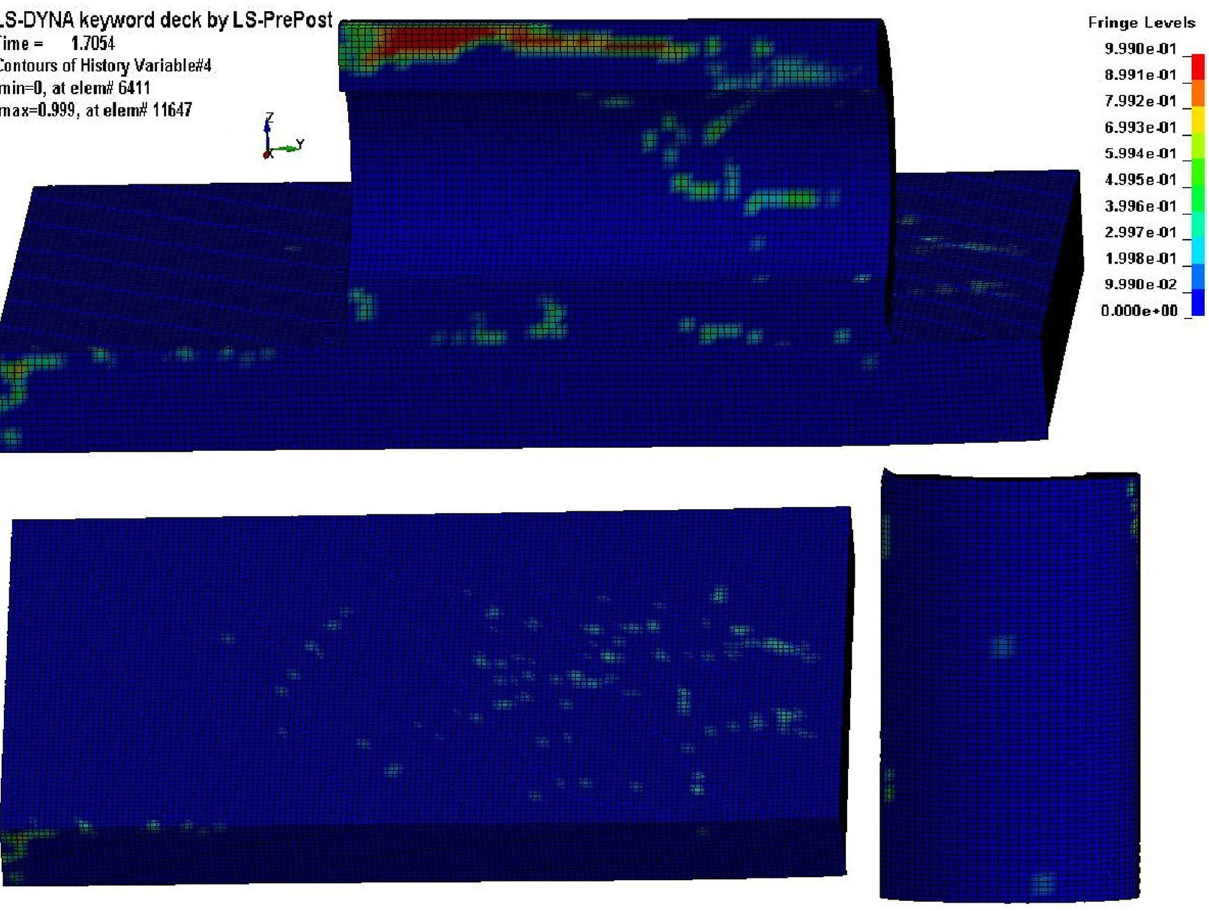
Fig. 18 Contours of brittle damage at t = 1.7054